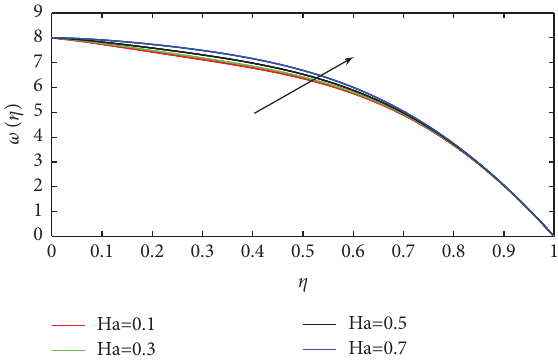
Figure 11: Temperature profles for the diferent values of . 1